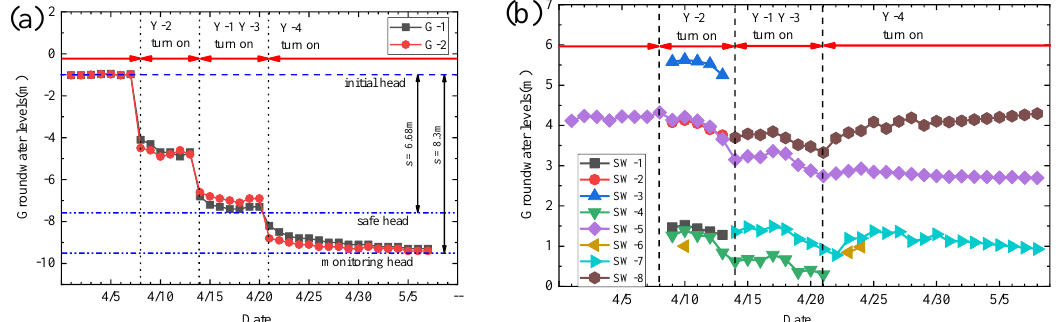
Figure 16. Groundwater level variation during excavation: ( a ) Aquifer top within the pit; ( b ) upper aquitard outside the pit.